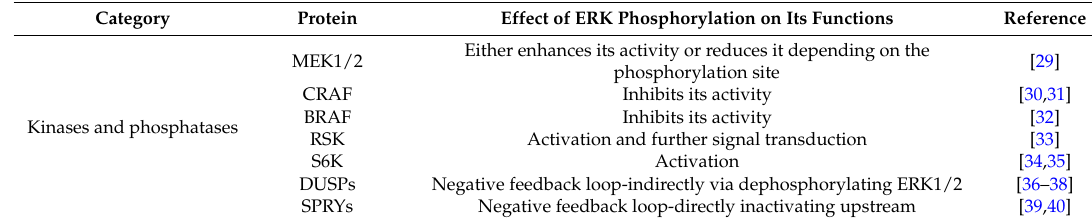
Table 1. Cellular targets of